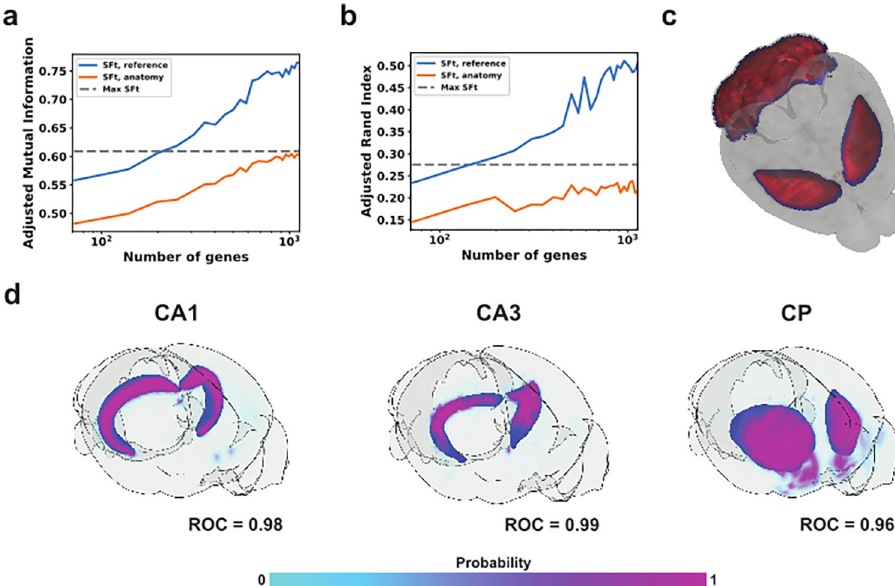
Fig 5. Performance metrics of compressed gene sets. Lower ranked genes across all SFt representations were iteratively removed from AMBA data, followed by SFt/clustering on the compressed dataset. (a) Adjusted Mutual Information between the full dataset vs. compressed representations and anatomy vs compressed representations. (b) Adjusted Rand Index of compressed representations vs full representations and anatomy. (c) Visualization of a selected feature derived from the SFt of the 2941-gene dataset (in red) with highest Pearson correlation to the 584-gene dataset (in blue), where 95% of the AMI score with reference is met. (d) Ten genes with the largest associated weights were used to train classifiers for their corresponding brain region. Probability of positive classification is shown by the colorbar, and the corresponding anatomy shown in blue. ROC score for five-fold cross-validation is shown for each method.